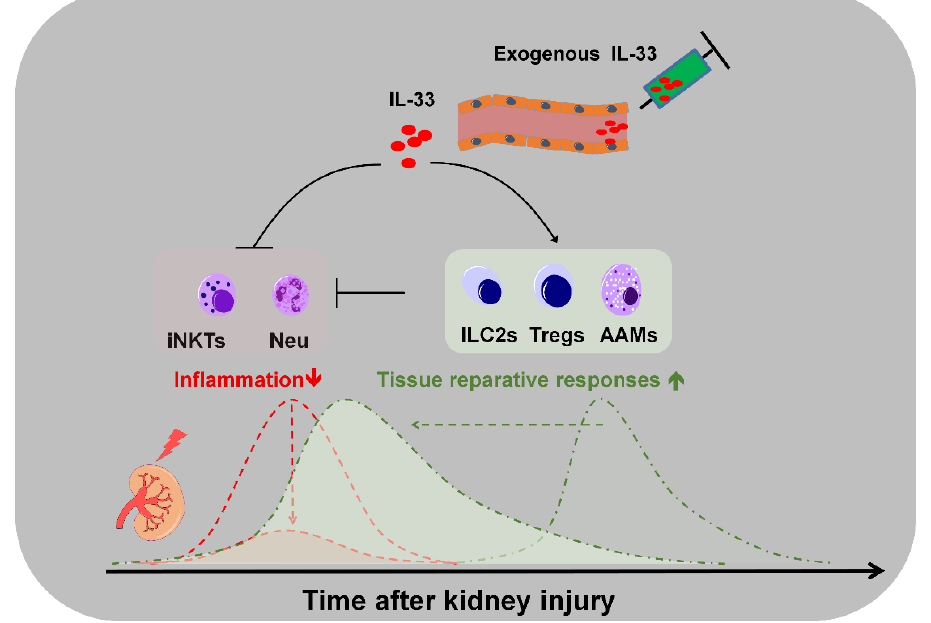
Figure 2. IL-33 treatment may promote tissue-reparative responses and inhibit inflammation in AKI. Treatment with exogenous IL-33 at different time points before or after kidney injury can mediate differential immune responses by targeting different immune cells. IL-33 treatment may skew the kidney ILC2s toward renal protective response. Additionally, IL-33 treatment following ischemia-reperfusion injury (IRI) could promote inflammation resolution and kidney repair potentially through ILC2- and AAM-derived factors. The renal protective function of exogenous IL-33 is potentially mediated by AAMs in the absence of endogenous ILC2s.